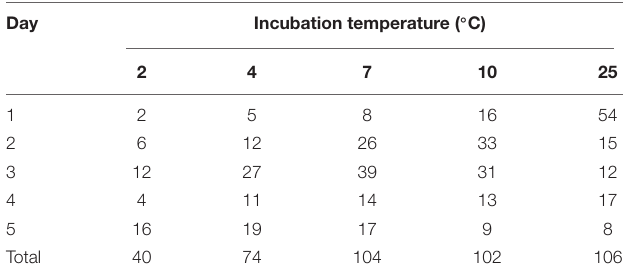
TABLE 2 | Pseudomonas spp. isolates 1 with observable proteolytic activity 2 at different